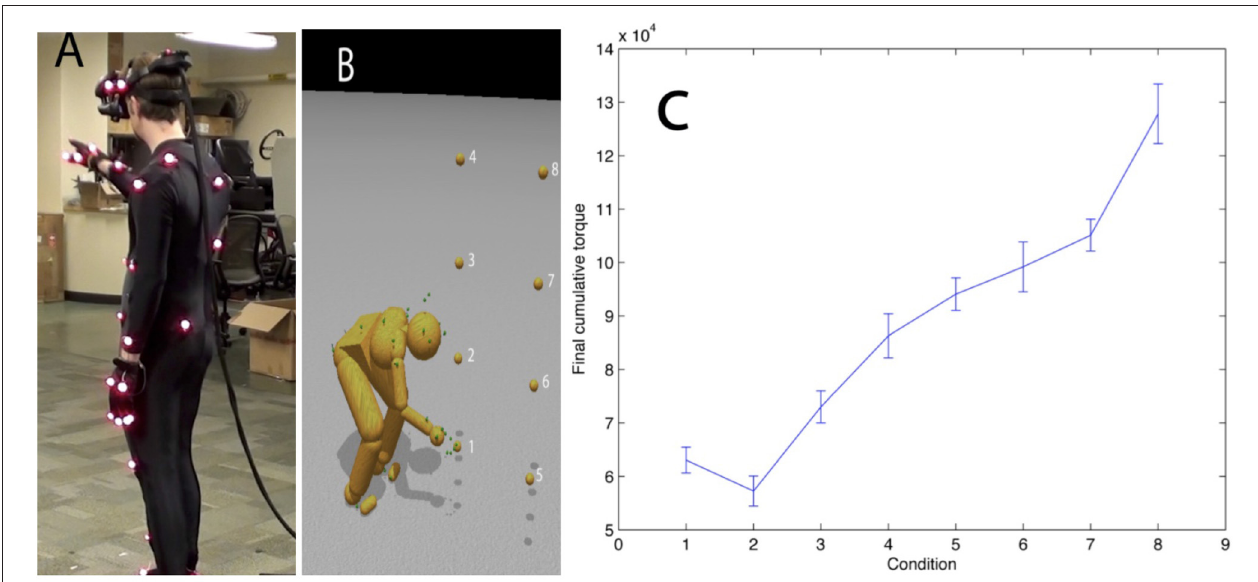
FIGURE 9 | Reaching in a virtual reality environment. (A) A subject reaches to touch virtual targets seen in a HMD. The subject’s reach is unconstrained. (B) The subject reaches to the different numbered targets on separate trials. (C) The average integrated torque over 10 trials per reach shows that the method reliably discriminates between movement costs for the further and higher